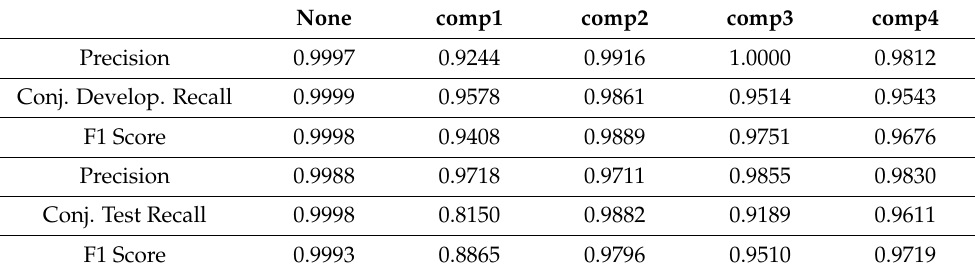
Table 14. Performance for the Random Forest model in the validation and test sets, with ’n_estimators = 70.